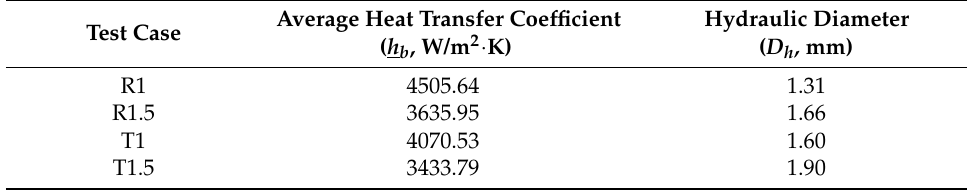
Table 3. Summary of average heat transfer